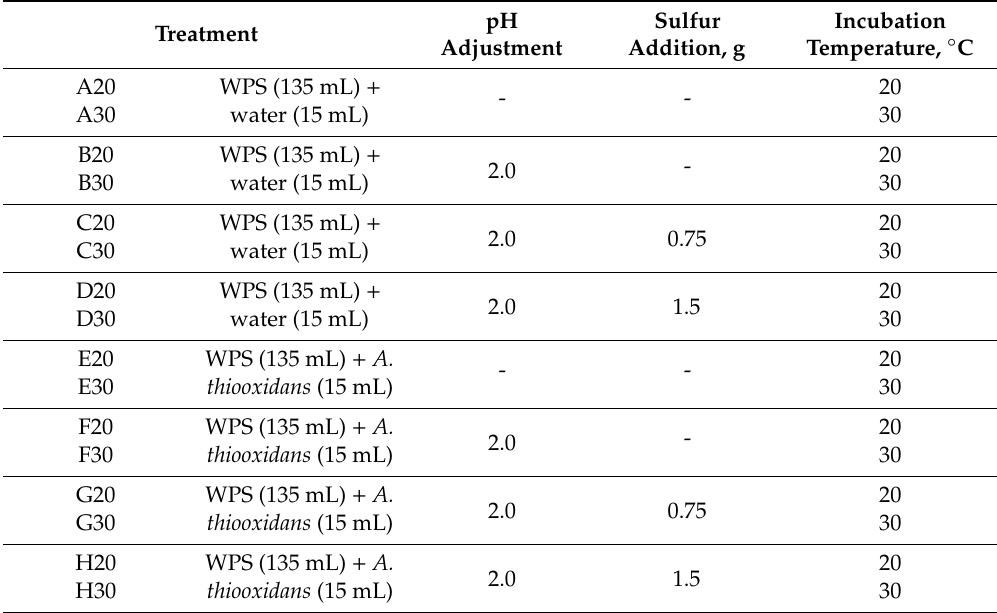
Table 3. Research combinations for water processing sludge (WPS)